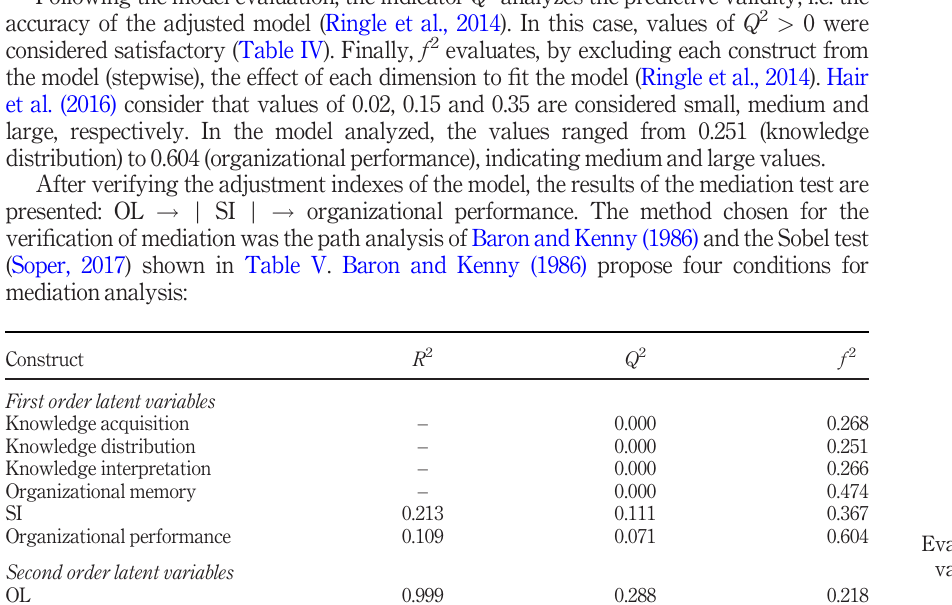
Table IV. Evaluation of